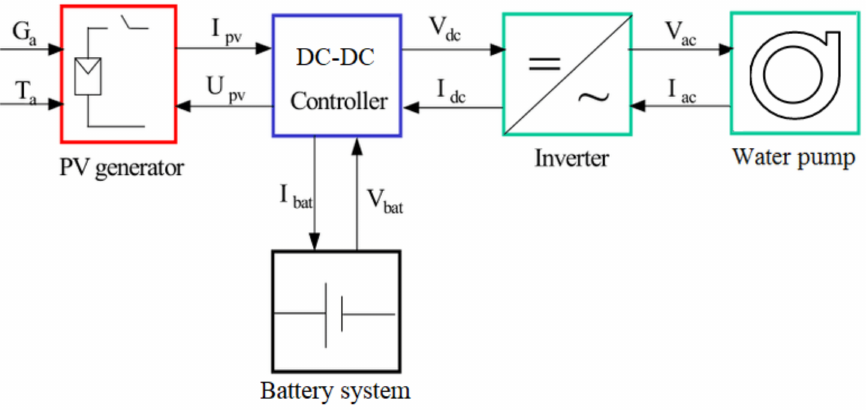
Figure 2. The block diagram of the PV pumping system architecture, off-grid